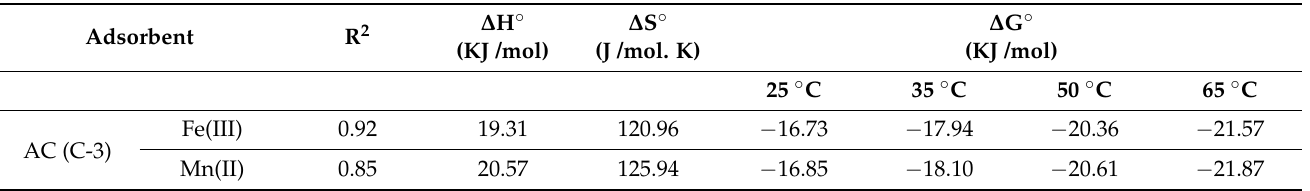
Table 12. Thermodynamic parameters for adsorption of Fe(III) and Mn(II) using AC(C-3), respectively.